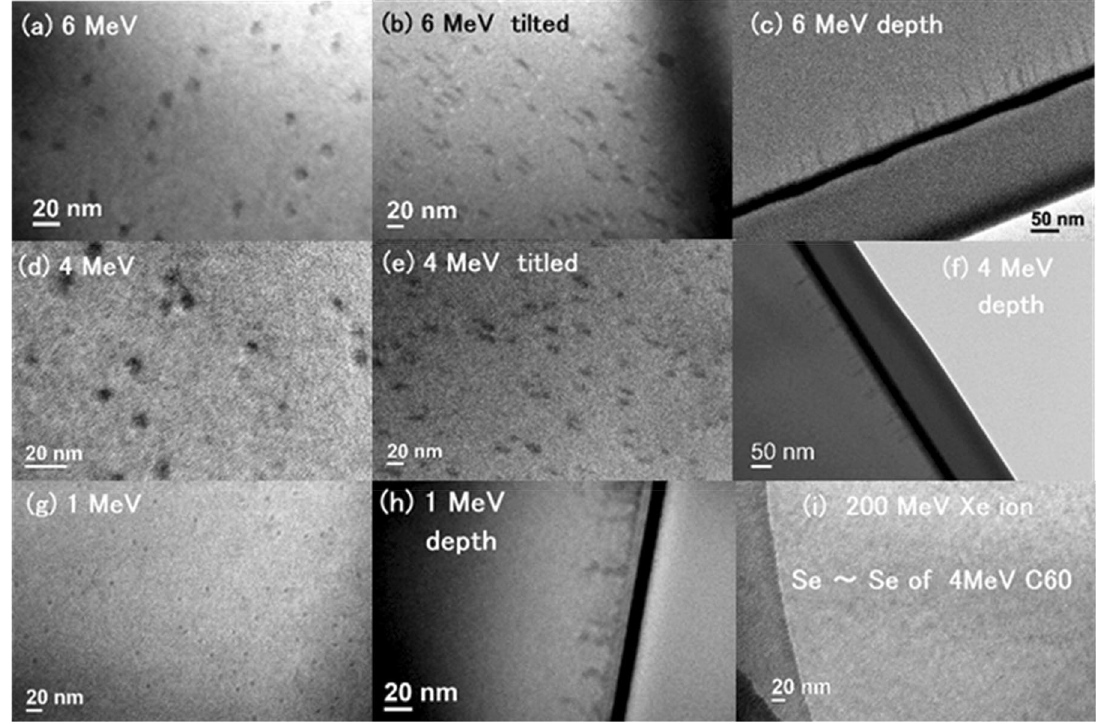
Figure 2. Bright-field TEM images of c-Si samples irradiated with ( a )–( c ) 6 MeV C 60 + , ( d )–( f ) 4 MeV C 60 + , ( g , h ) 1 MeV C 60 + , and ( i ) 200 MeV Xe 14+ ions. All the samples were prepared by the pre-thinned configurations, except ( c ), ( f ), and ( h ) by the post-thinned configurations. Although both 200 MeV Xe 14+ ions and 4 MeV C 60 ions provide almost the same S e in c-Si, tracks were not observed in the former case, as shown in ( i ). While 4 and 6 MeV C 60 + ions exhibit almost straight tracks ( c , f ), 1 MeV C 60 + ions exhibit skewed tracks, which could indicate crossover from ion tracks to collision